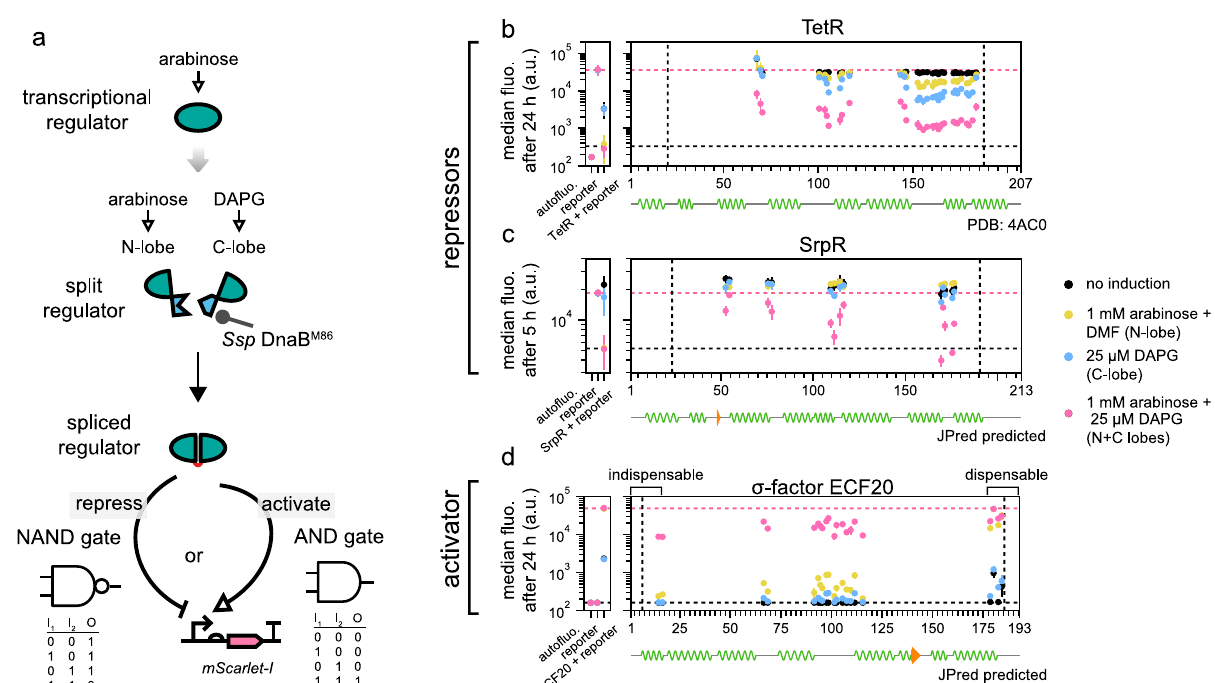
Fig. 2 IBM as a universal method to exhaust split sites for AND and NAND logic gate engineering. a Any transcription factor with a function that can be wired to an assay-friendly output could be subjected to IBM for logic gate engineering. b – d Intein-bisection maps for TetR ( b , 3 seams identi fi ed), SrpR ( c , 4 seams), and ECF20 ( d , 3 seams). Split clones of TetR and SrpR (or ECF) achieved major off (or on) activities when both the N-lobes and the C-lobes were present. y locations and error bars are mean and SD of median fl uorescence from experiments performed on three different days ( n ≥ 3, see Supplementary Data 2, sheet “ sample_sizes ” for exact values of n ). Vertical dashed lines bound the permitted transposition window and horizontal dashed lines bound